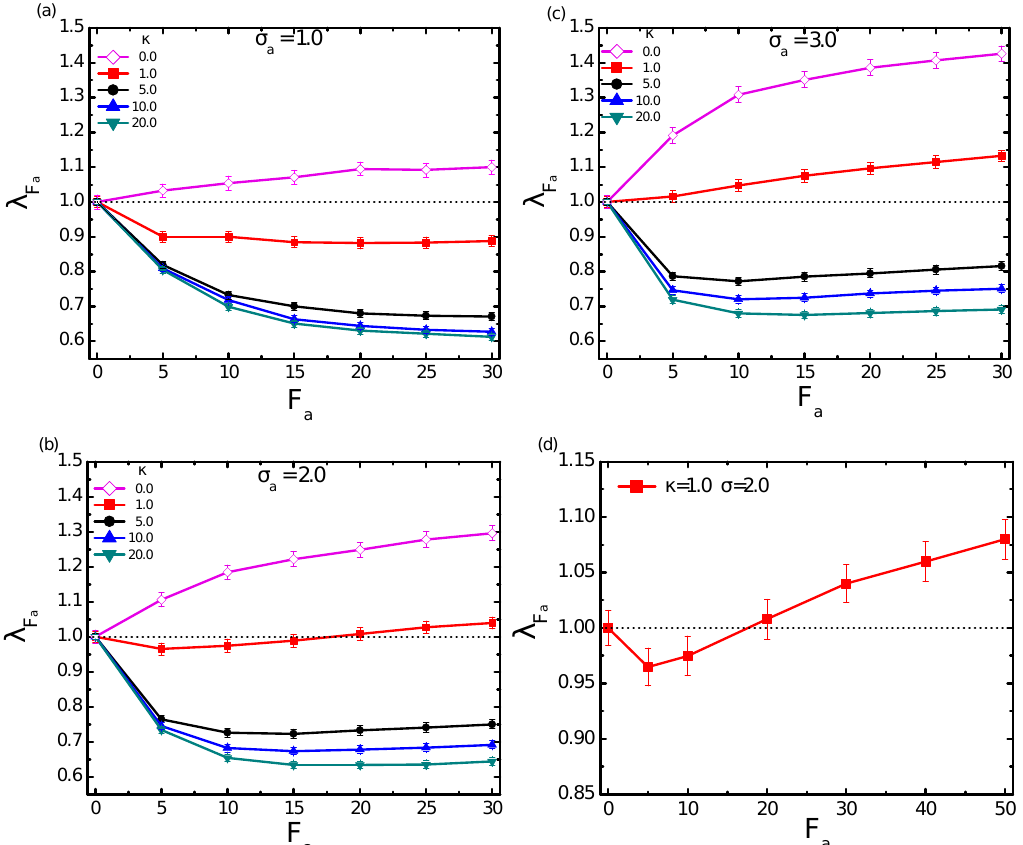
Figure 2. Scaled gyration radius λ F as a function of active force F a for polymers with different rigidities a κ , under three typical crowder sizes: σ a = 1.0 ( a ); σ a = 2.0 ( b ); and σ a = 3.0 ( c ). ( d ) The magnification of the curve under κ = 1.0 and σ a = 2.0, with a larger range of active force. The volume fraction is fixed at φ = 0.1. Error bars represent one standard deviation.